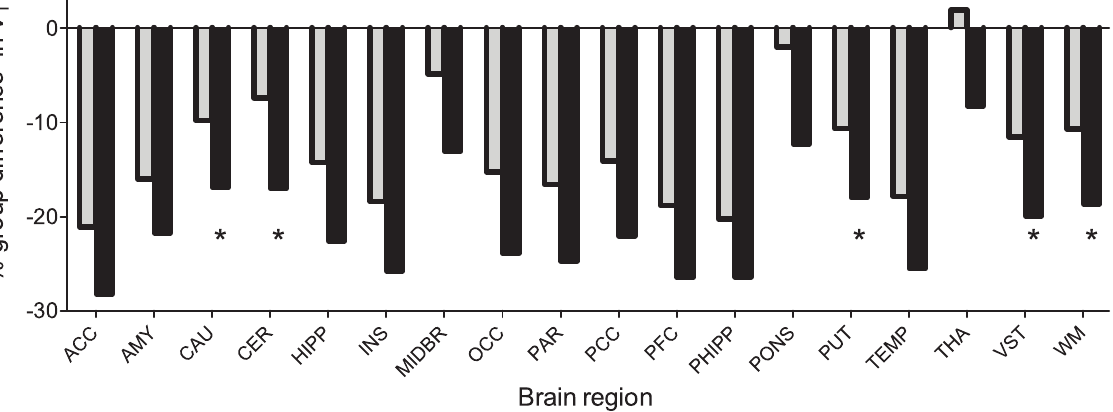
Figure 3. Regional percent differences in [ 18 F]FMPEP- d 2 V T between healthy subjects and chronic cannabis smokers. V T values are estimated by the Logan method with full arterial input curve (gray bars) and with PBIF (black bars). Compared with full arterial input modeling, PBIF underestimated V T by about 9% in the cannabis group and erroneously showed statistically significant downregulation in subcortical regions that did not differ in either compartmental kinetic modeling or Logan full arterial input modeling